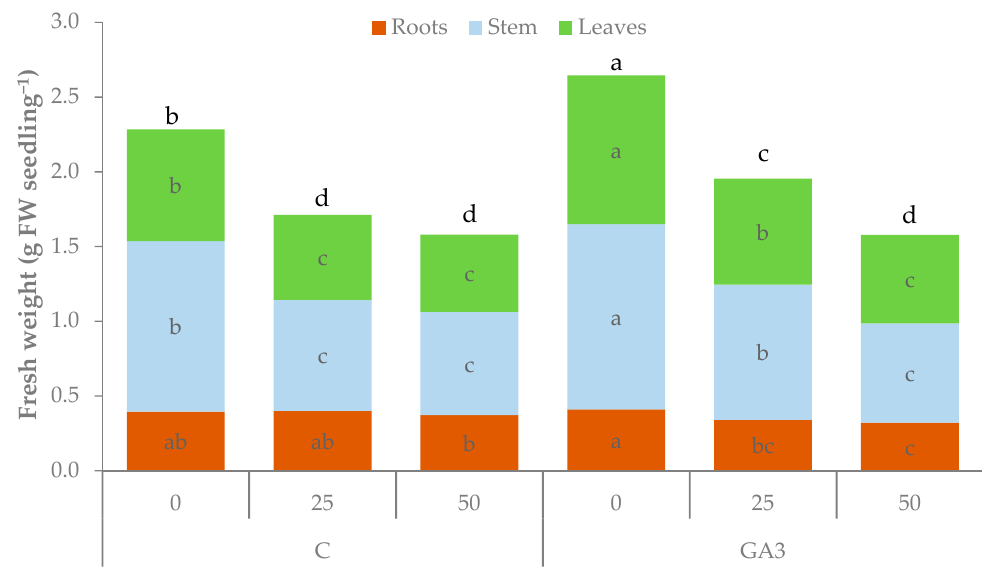
Figure 4. E ff ect of the seedling treatments (C, untreated control, GA3, gibberellic acid spray 10 − 5 M) and salt stress (0, 25, and 50 mM NaCl in the irrigation water) on the total, root, stem, and leaf fresh weight of tomato seedlings. Bbars of the same color with di ff erent letters are significantly di ff erent at p < 0.05 according to the LSD test.